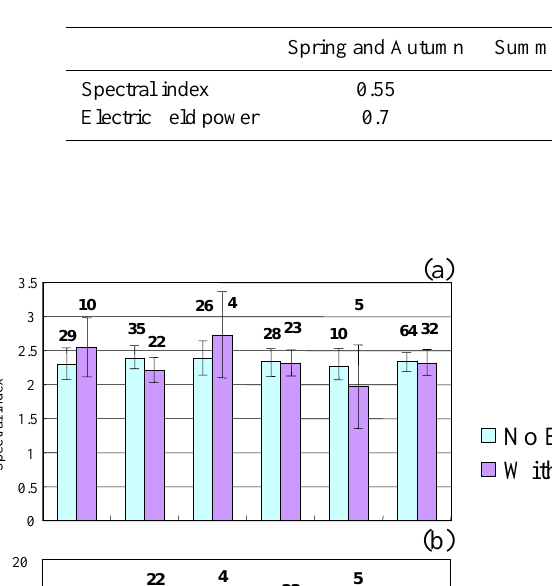
Table 3. The probability to have different parent distributions between seismic and non seismic periods corresponding to the groups in Figure 6(a) and 6(b).